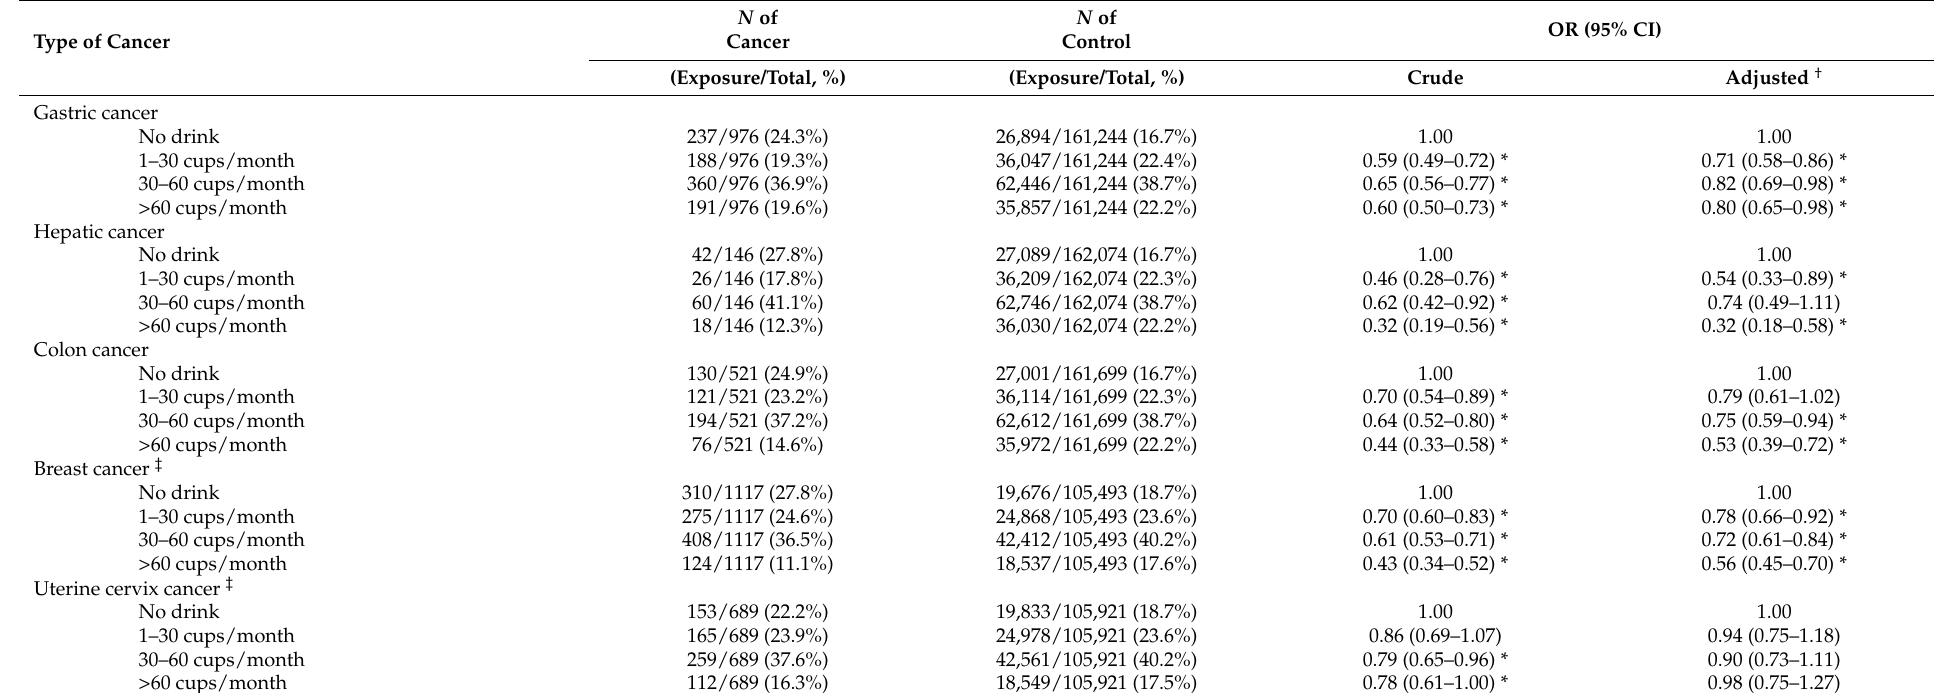
Table 2. Crude and adjusted odd ratios (95% confidence interval) of coffee drinking habit for various cancer